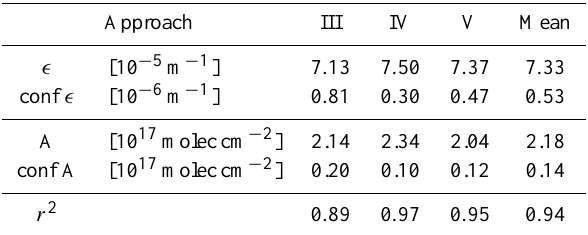
Table 5. Results from the fits to the radiative transfer models. (cid:15) and the ± 1 to calculate confidence bands of 95% (conf (cid:15) ) are given in [ 10 − 5 m − 1